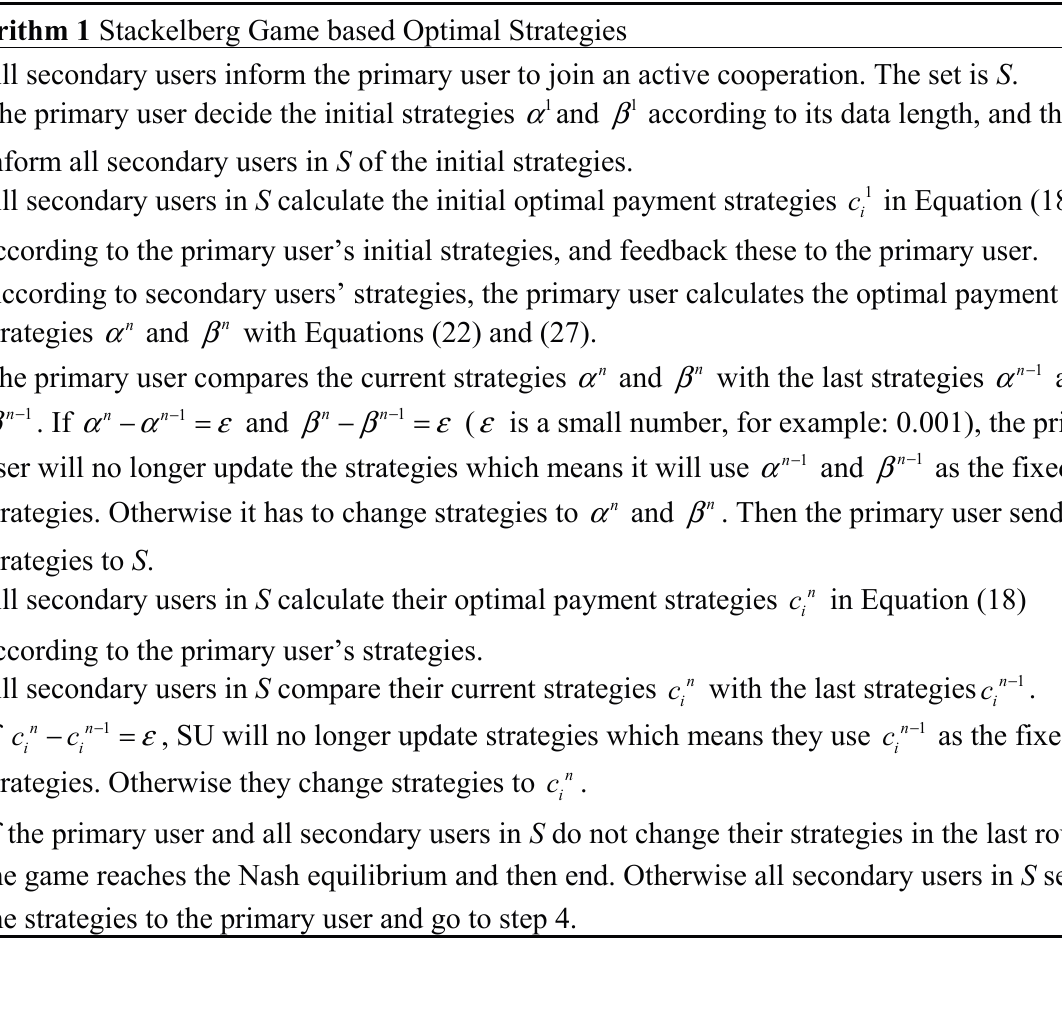
Algorithm 1 Stackelberg Game based Optimal